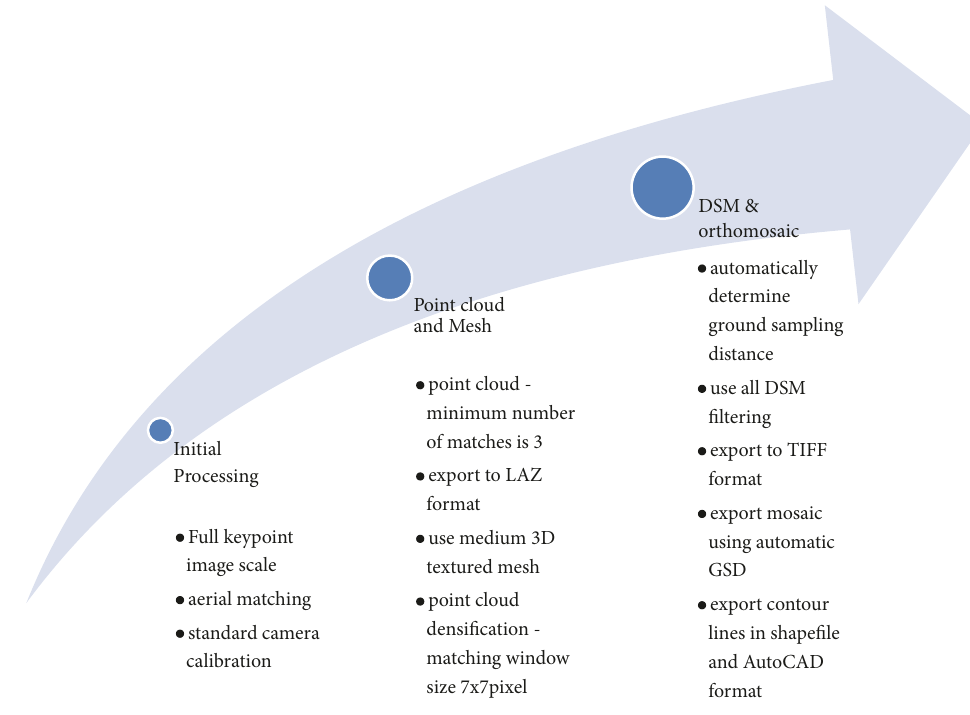
Figure 7: Pix4D image processing